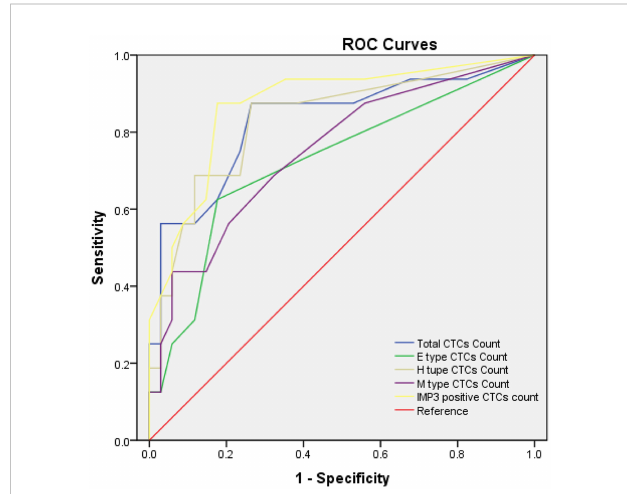
FIGURE 6 ROC curves for total CTC count and IMP3-positive CTC count. The best cutoff value was 6.5 cells/5ml of peripheral blood for total CTC count and four cells/5ml of peripheral blood for IMP3-positive CTC count according to the maximization of Younden index from the ROC curve analysis. Each experiment was repeated for three times, and each group had six replicates.